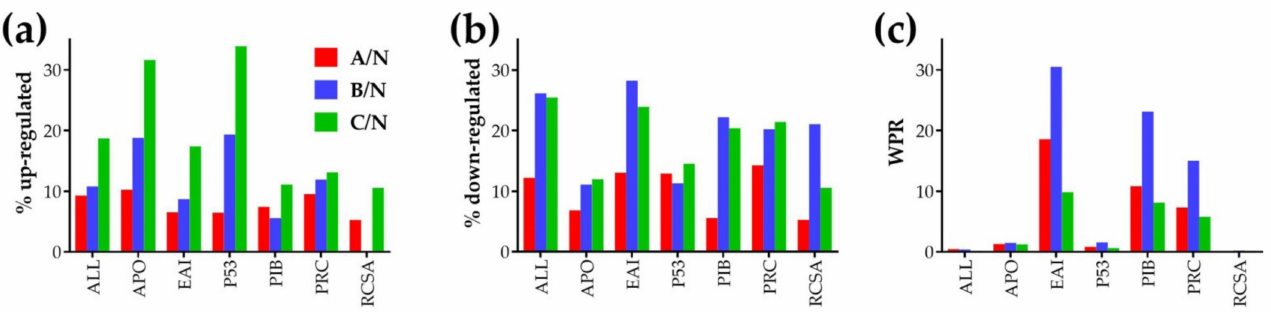
Figure 3. Overall regulation of selected KEGG-determined functional pathways measured by the percentages of the significantly down- ( a ) and up-regulated ( b ) genes, and by the Weighted Pathway Regulation (WPR) ( c ). ALL = all genes, APO = apoptosis, EAI = evading apoptosis + immortality, P53 = P53 signaling, PIB = proliferation + insensitivity to antigrowth signals + block of differentiation, PRC = prostate cancer, RCSA = resistance to chemotherapy and sustained